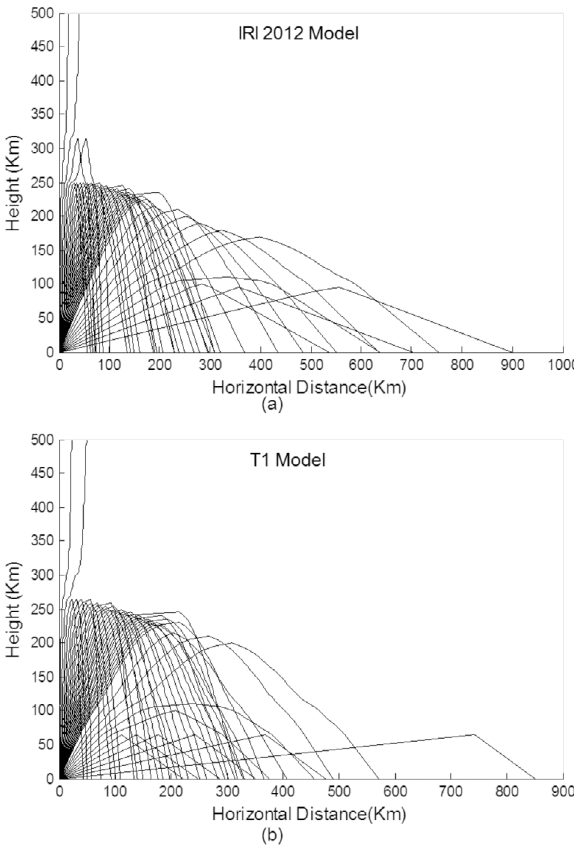
Figure 3. Ray tracing at 7.5 MHz for different angle of incidence under Case 1 and under influence of Earth’s magnetic field when the background is, (a) IRI 2012 model of the ionosphere and (b) T1 model of the